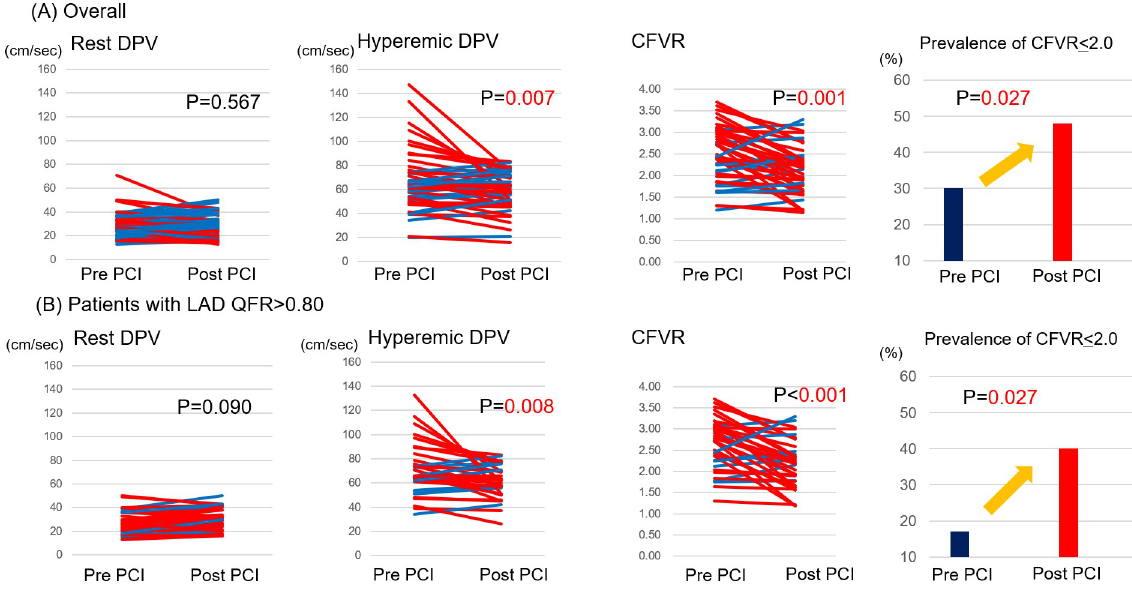
Fig 2. Changes in LAD-hDPV and LAD-CFVR after non-LAD PCI. After non-LAD PCI, LAD-hDPV and CFVR significantly decreased, whereas no significant change in LAD-bDPV was observed. (A) In a total cohort, the prevalence of LAD-CFVR of � 2.0 after non-LAD PCI showed an increasing trend. (B) In the subgroup analysis of patients with functional less severe LAD stenosis (QFR > 0.80), the prevalence of LAD-CFVR of � 2.0 after non-LAD PCI was significantly increased. Abbreviations as in Fig 1.